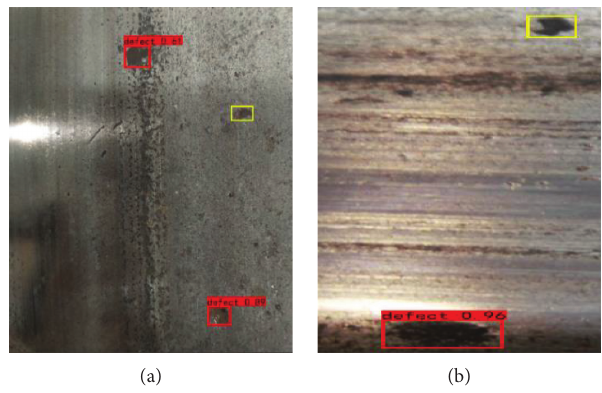
Figure 13: Missing case. (a) Missed detection. (b) Wrong